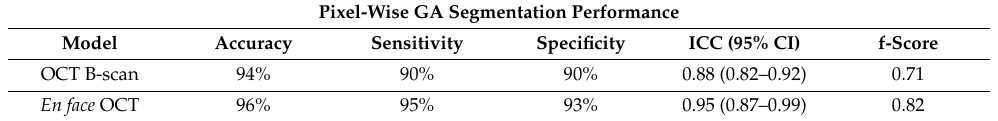
Table 2. Summary of pixel-wise GA segmentation performance for both OCT B-scan and en face OCT models. ICC: interclass correlation coefficient; CI: confidence interval; GA: geographic atrophy, OCT: optical coherence tomography.